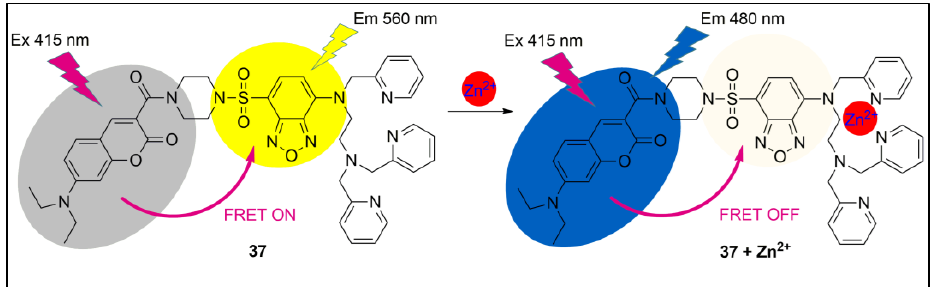
Figure 38. Chemical structure of 37 and schematic illustration of its ratiometric Zn 2+ sensing mechanism [119].